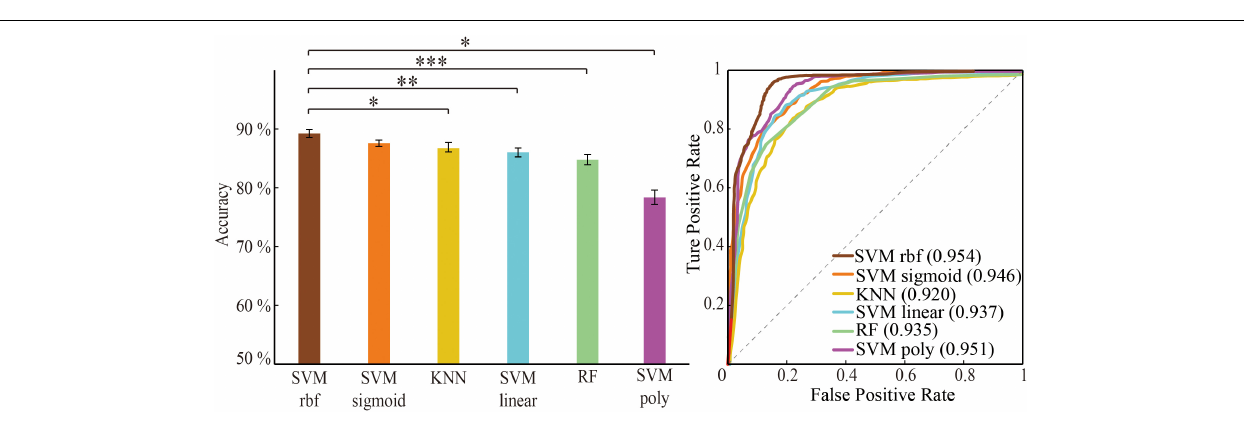
Frontiers in Aging Neuroscience |